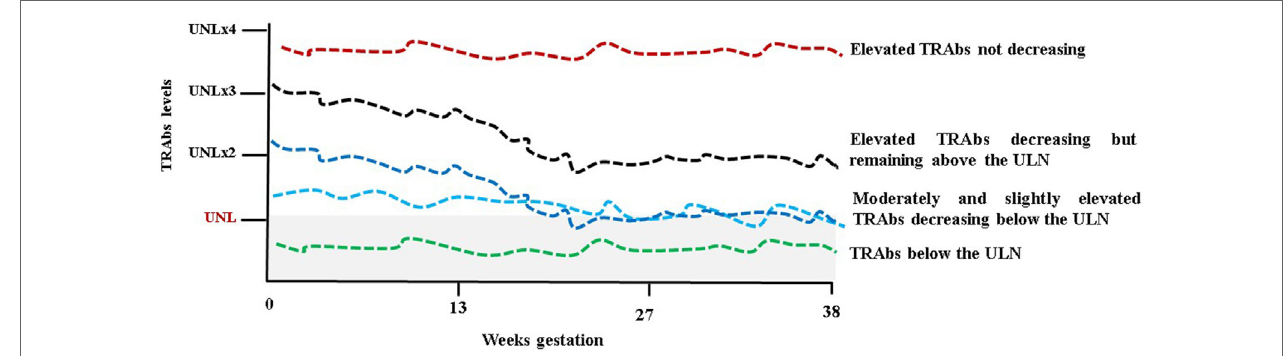
FiGURe 2 | Schematic representation of TSH receptor antibodies (TRAbs) behavior during pregnancy. UNL, upper normal limit and (x) multiples. The gray shaded area represents the normal